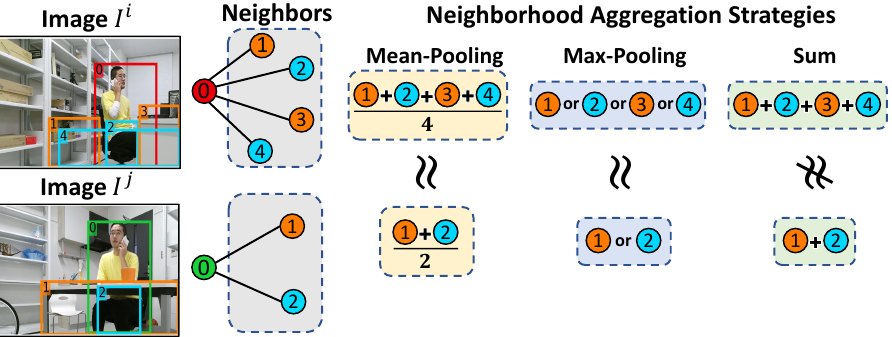
Figure 4. Toy examples for different aggregation strategies to discriminate the neighbors of the no. 0 regions in I i and I j . The numbers and colors of regions in the image and the nodes in the graph correspond to each